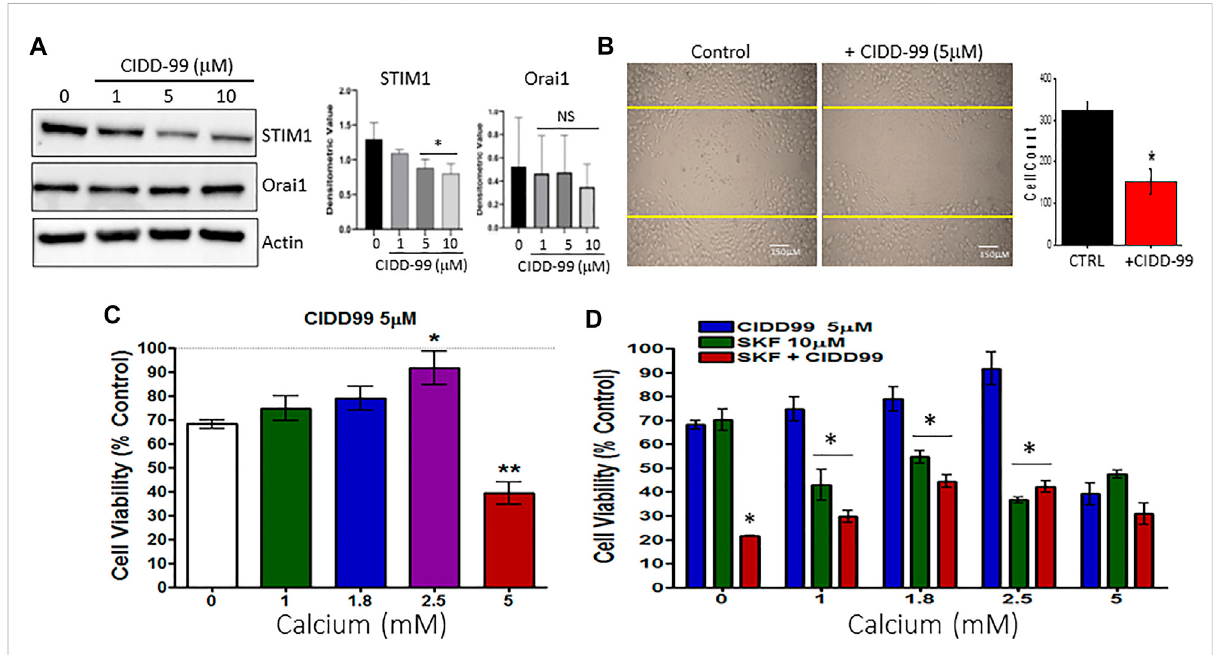
OSCC cells treated with CIDD-99 show downregulation of STIM1 and increase cell migration. (A) Cal-27 cells were treated with CIDD-99 at concentrations of 0, 1, 5 and 10 µM for a period of 24 h. After 24 h, cells were lysed and analyzed for calcium channel proteins, STIM1 and ORAI1. Quanti fi cation ( n = 3) is shown as bar graph (mean ± SD) on the right. * Indicates signi fi cantly different (T-test) from control untreated p < 0.05, NS indicatesnosigni fi cantdifference. (B) Cellmigrationassayswereperformedwherecellsweregrownfor24 hscratchedusingapipettewithand without required CIDD-99 and images were taken after 24 h using a ×20 objective. Quanti fi cation is shown as bar graph, where * indicates signi fi cance ( p < 0.05, using one-way ANOVA, n = 4) from un-treated control. (C) Cell viability assay of Cal-27 cells treated with 5 µM CIDD-99 and increasing calcium concentrations for 24h; * p < 0.05, and ** p < 0.001 (using one-way ANOVA, n = 4 with 3 independent replicates). (D) Cell viability assay of Cal-27 cells treated with 5 µM CIDD-99 and in combination with 10 µM SKF and increasing calcium concentrations. Bar graph